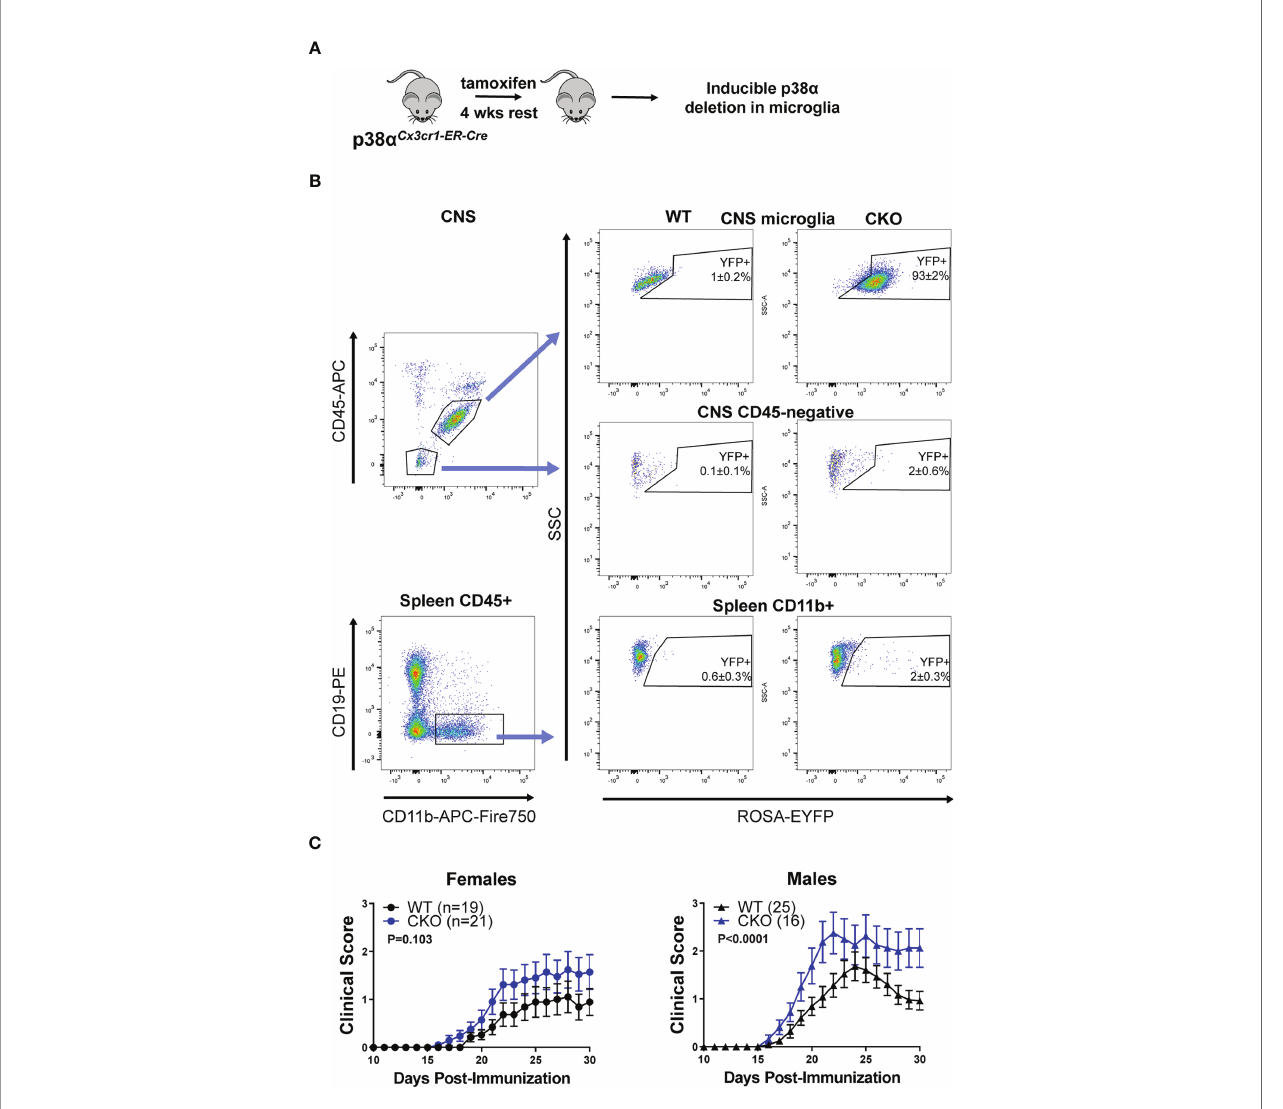
FIGURE 3 | Deletion of p38 a in microglia using inducible Cx3cr1 -CreER exacerbates EAE in male mice. (A) A schematic illustrating the approach to targeting of genetic deletion to speci fi c cell types used in Figure 3. (B) 6-12 week old ROSA-EYFP+p38 a CKO Cx3cr1-ER and WT control mice were treated with 2.4 mg tamoxifen i.p. for 4 days, followed by a 4 week rest period. Spleen cells and CNS mononuclear cells were isolated from p38 a CKO Cx3cr1-ER mice as described in the Materials and Methods and analyzed by fl ow cytometry. Reporter EYFP expression in CNS microglia (top panel; CD11b + CD45 INT ), CD45-negative CNS cells (middle panel), and spleen myeloid cells (CD45 + CD19 - CD11b + ) isolated from CKO (p38 a CKO Cx3cr1-ER ROSA-EYFP+) or WT (p38 a fl / fl Cre-negative ROSA-EYFP+ littermates) mice. (C) 6-12 week old female and male p38 a CKO Cx3cr1-ER and WT control mice were treated with 2.4 mg tamoxifen i.p. for 4 days, followed by a 4 week rest period, at which point EAE was induced and evaluated as described in Materials and Methods. P value indicates signi fi cance of difference in EAE course between WT and CKO, calculated as in . Sample size for each sex/genotype is indicated in parenthesis the panel